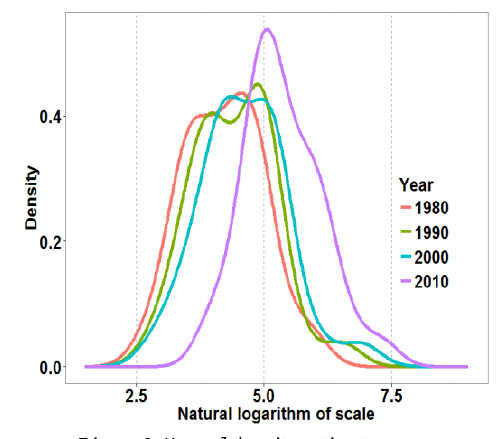
Figure 9. Kernel density